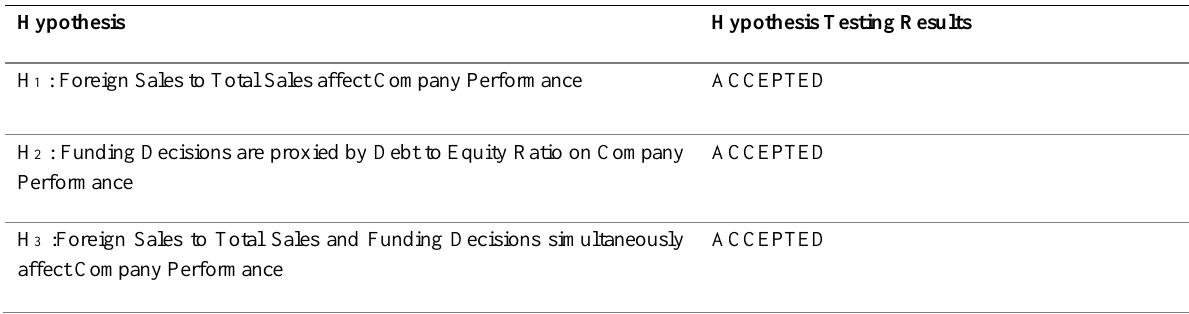
Table 9: Summary of Research